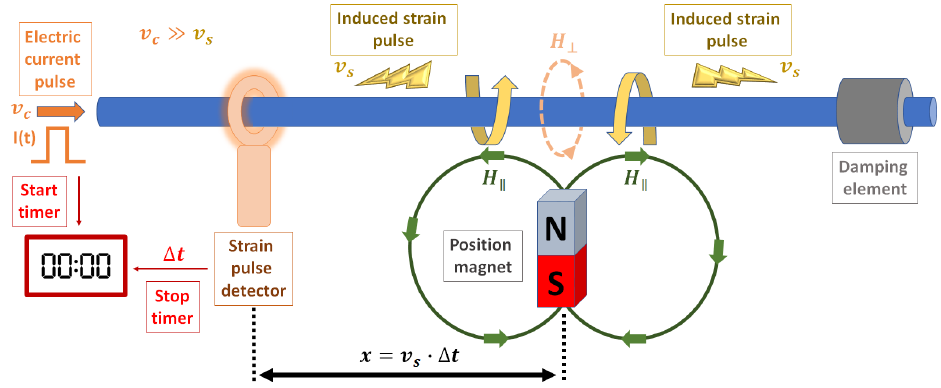
Figure 3. Schematic of a magnetostrictive linear position sensor based on the Wiedemann